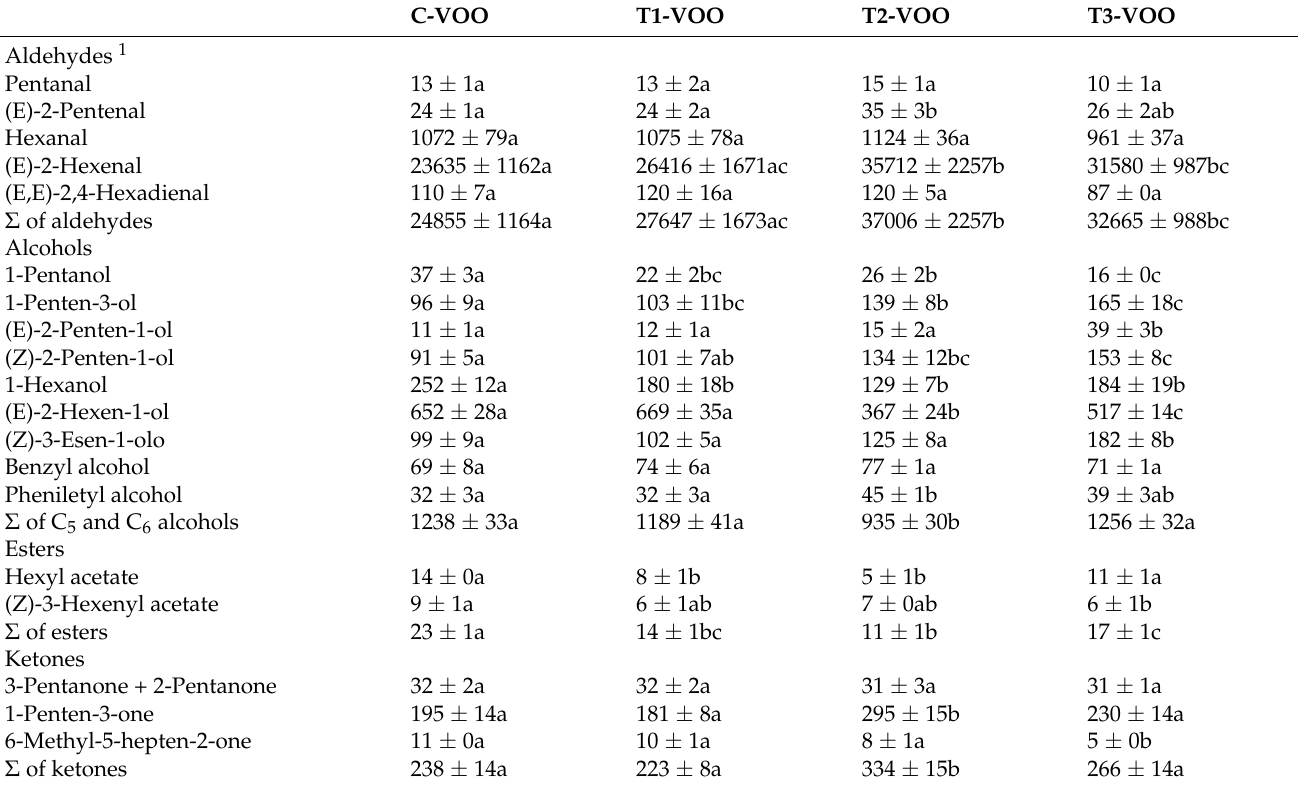
Table 3. Volatile composition ( µ g/kg) of Canino VOOs extracted at different temperatures.